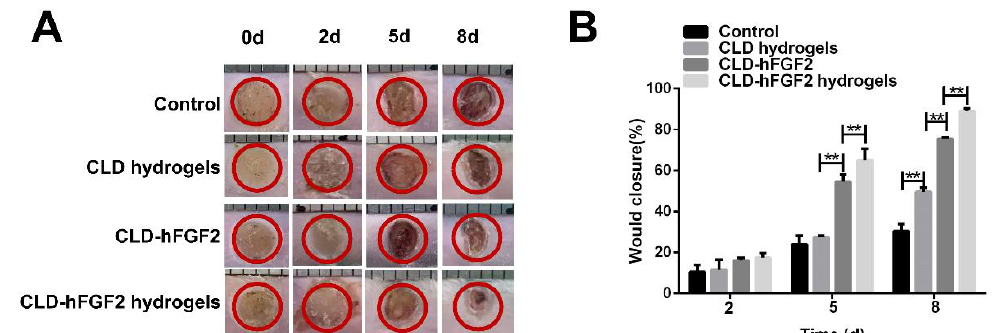
Figure 4. CLD-hFGF2 hydrogels accelerate deep second-degree burn wound healing. ( A ) Images of skin wounds after being covered with PBS, CLD hydrogels, CLD-hFGF2, and CLD-hFGF2 hydrogels. ( B ) Wound healing rates on the 0th, 2nd, 5th, and 8th days (n = 6, ** p < 0.01). On day 5, the healing rate of the CLD-hFGF2 hydrogel group reached 69%, and treatment with CLD-hFGF2 alone also showed a relatively high healing rate (52%) compared